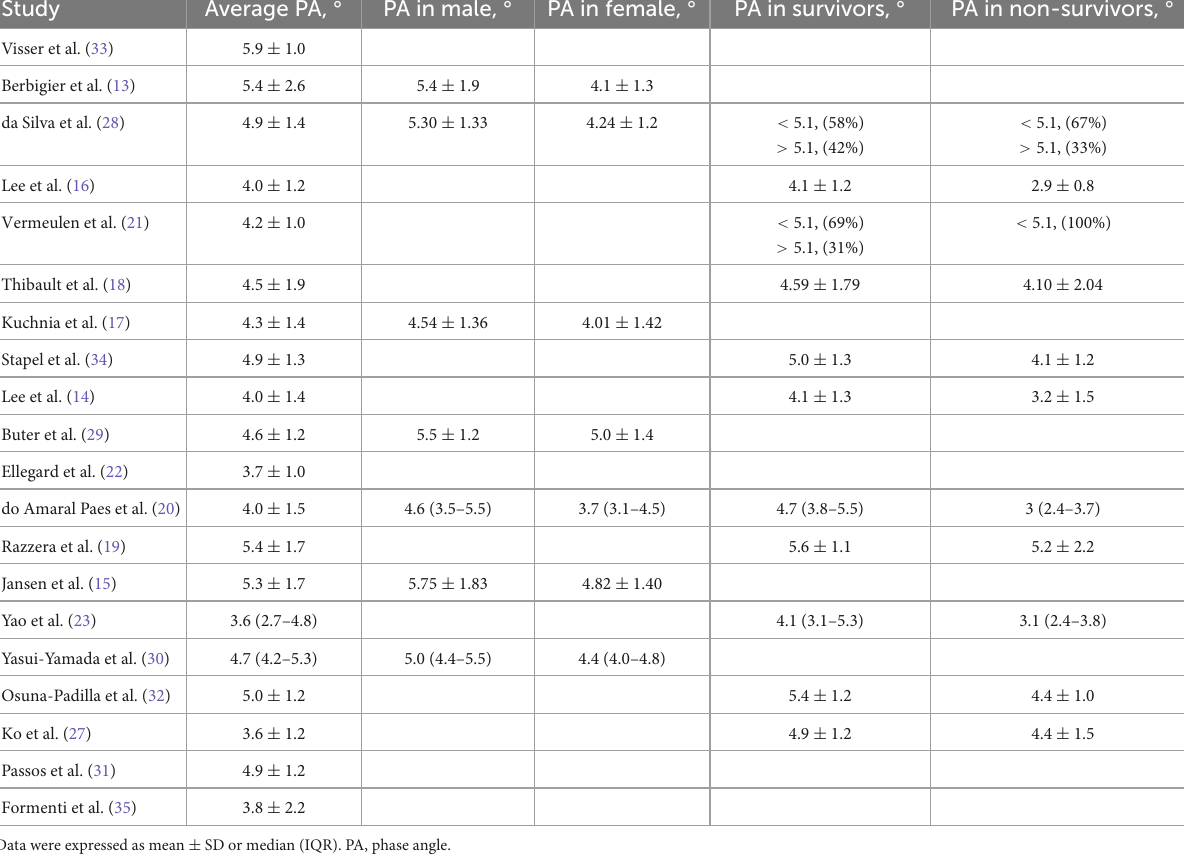
TABLE 2 Phase angle (PA) levels in the included studies on admission.